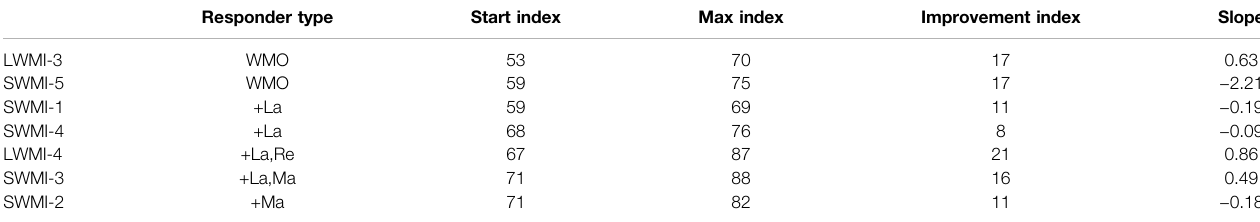
TABLE 4 | Progress scores from working memory training